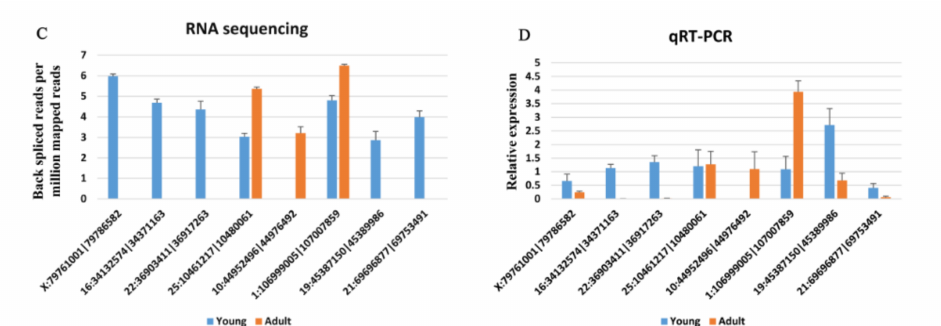
Figure 2. Validation of eight DE circRNA expression levels. ( A ) Electrophoretogram of the qRT-PCR products of the eight circRNAs obtained with divergent primers. M: marker 500. ( B ) Sanger sequencing of the eight circRNAs confirms the head-to-tail splicing. ( C ) Expression pattern of the eight circRNAs between young and adult Chinese bu ff alo adipose tissue based on RNA sequencing. ( D ) Validation of the expression pattern for the eight DE circRNAs by qRT-PCR. All of the eight circRNAs confirmed the RNA sequencing pattern. Data are presented as the means ± SEMs, n = 3. Animals 2019 , 9 , x